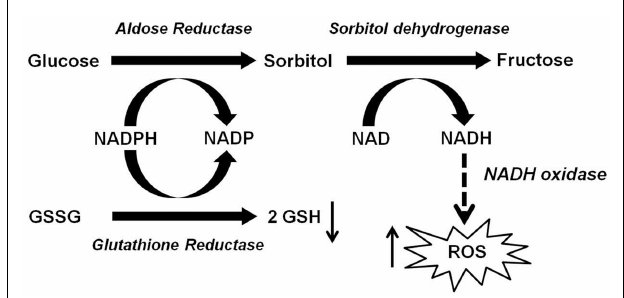
FIGURE 1 | Role of aldose reductase (AR) in hyperglycemia-induced oxidative stress. Excessive amount of glucose is shunted to the polyol pathway, where AR reduces glucose into sorbitol at the expense of NADPH. Since NADPH is essential for generation of GSH (intracellular antioxidant) from GSSG, the depletion of NADPH by the AR pathway may impair intracellular antioxidant defense. Sorbitol is then converted to fructose by SDH with the production of NADH, potentially leading to increased ROS via NADH